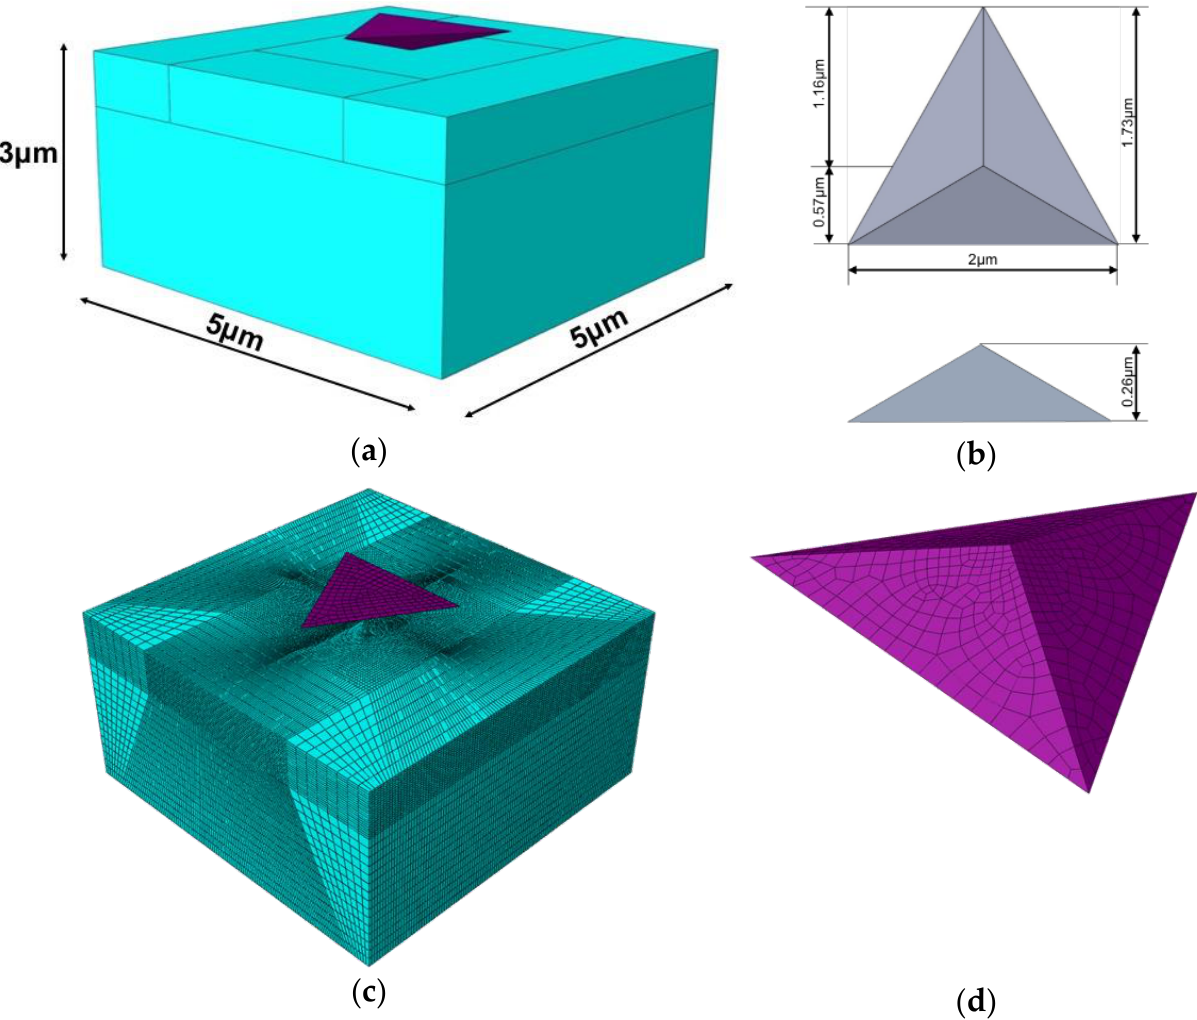
Figure 5. Three-dimensional finite element model of the nanoindentation: ( a ) the dimensions of the target material, ( b ) the dimensions of the Berkovich indenter, ( c ) the meshed model and ( d ) the meshed Berkovich indenter.